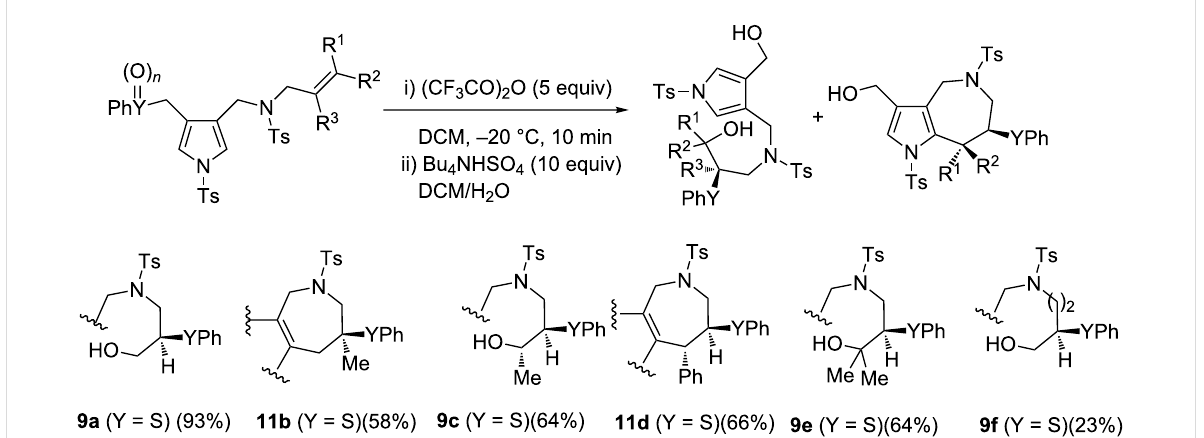
Scheme 3: Substrate scope of 1,7-S and 1,7-Se shift